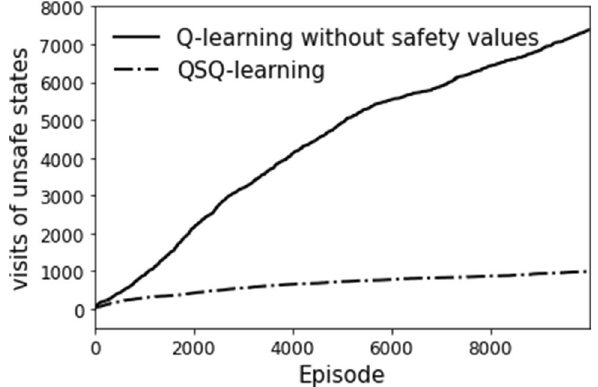
Figure 11. The evolution of visiting unsafe states.